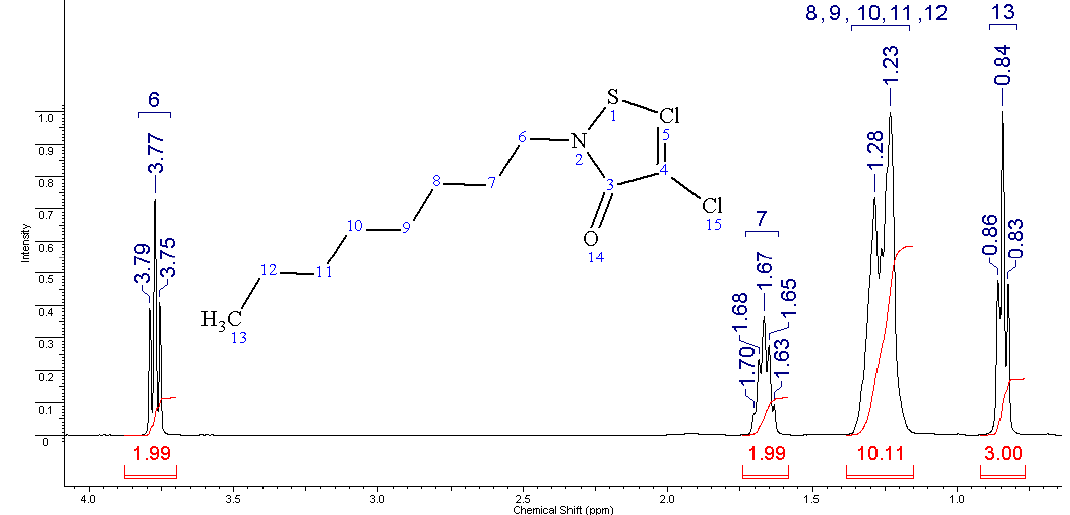
Figure 5. 1 H NMR spectra of DCOIT.